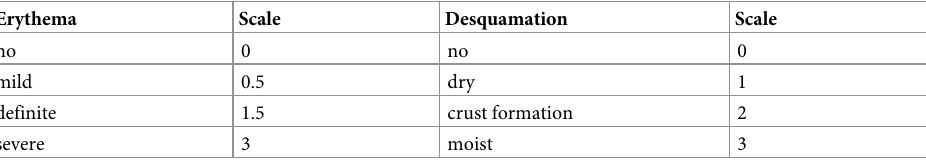
Table 1. Skin response score